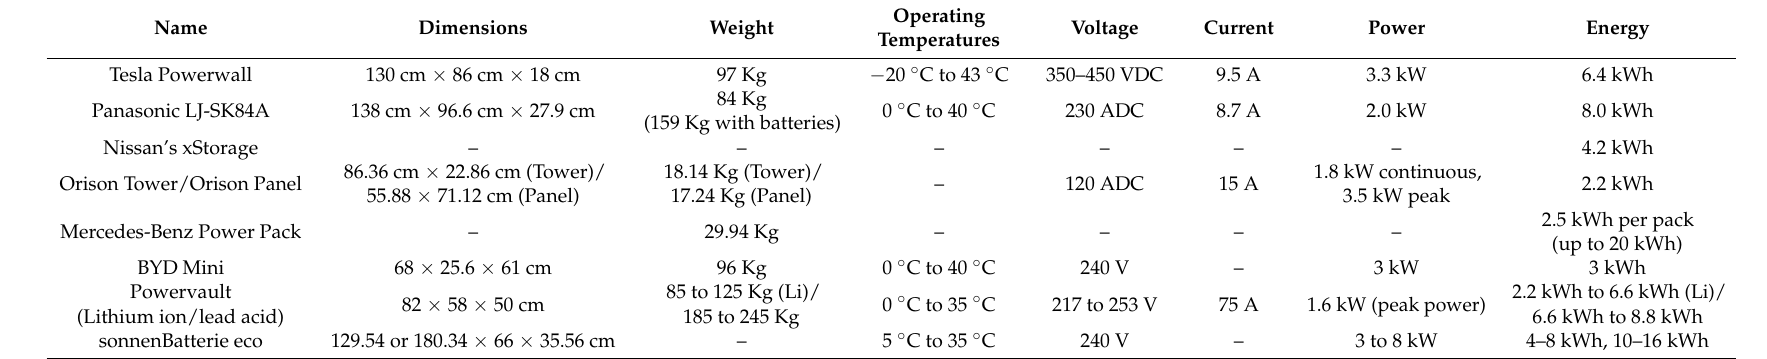
Table 1. Main features of available home